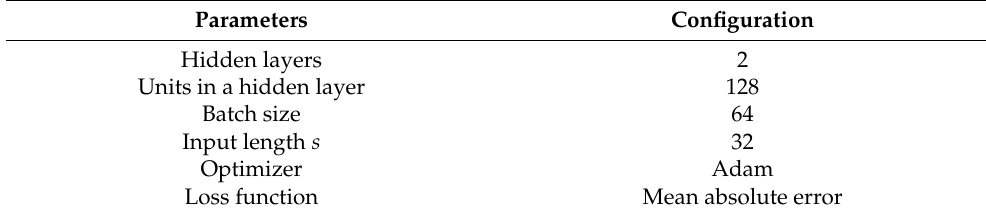
Table 1. Parameters of LSTM